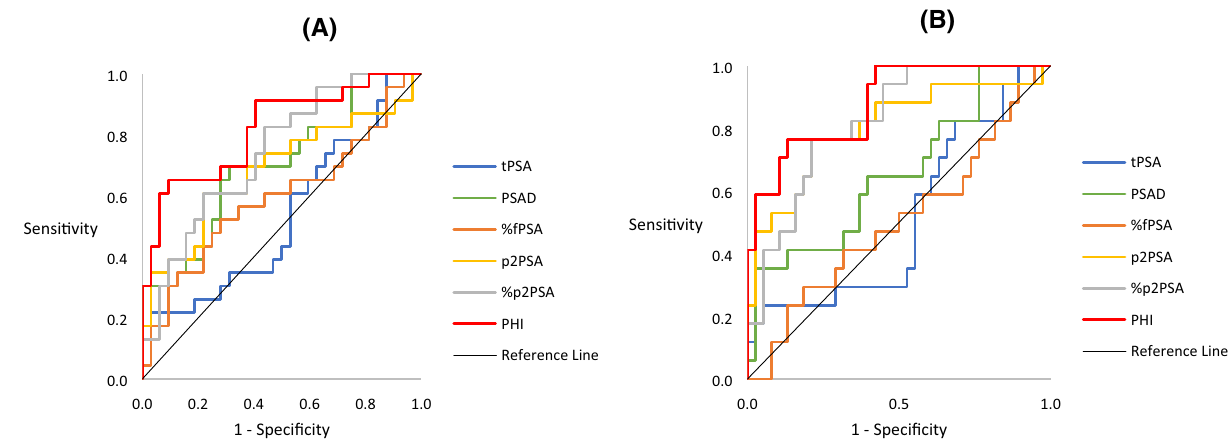
Figure 2. Receiver operating characteristic (ROC) curve for PHI to predict prostate cancer in patients with PI-RADS = 3. ( A ) Total prostate cancer; ( B ) Clinically significant prostate